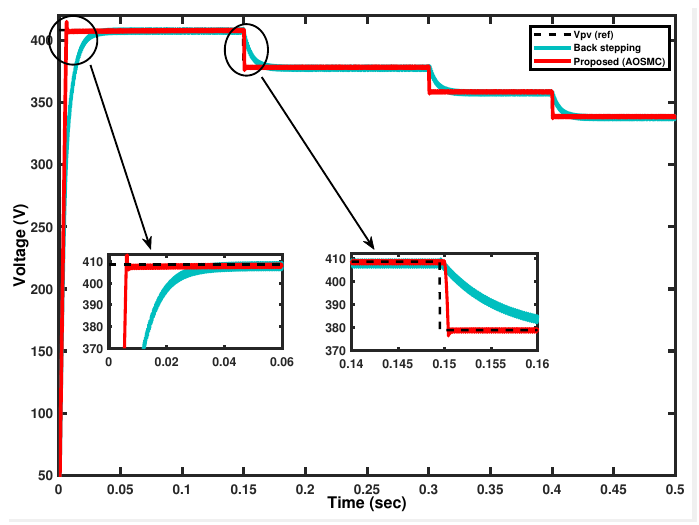
Figure 19. Comparison of voltage PV system under varying temperature.